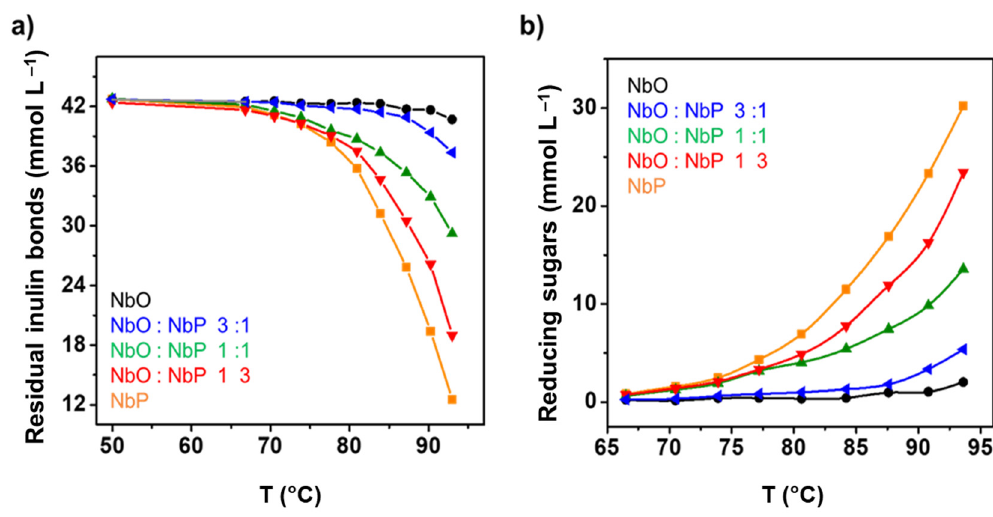
Figure 5. Results of the batch catalytic reaction of inulin hydrolysis in water on NbO, NbP, and relevant NbO:NbP mixtures as a function of reaction temperature (from 50 to 90 °C with linear increase of 0.12 °C min − 1 ), expressed as residual inulin bond concentration ( a ); and reducing sugar concentration ( b ).